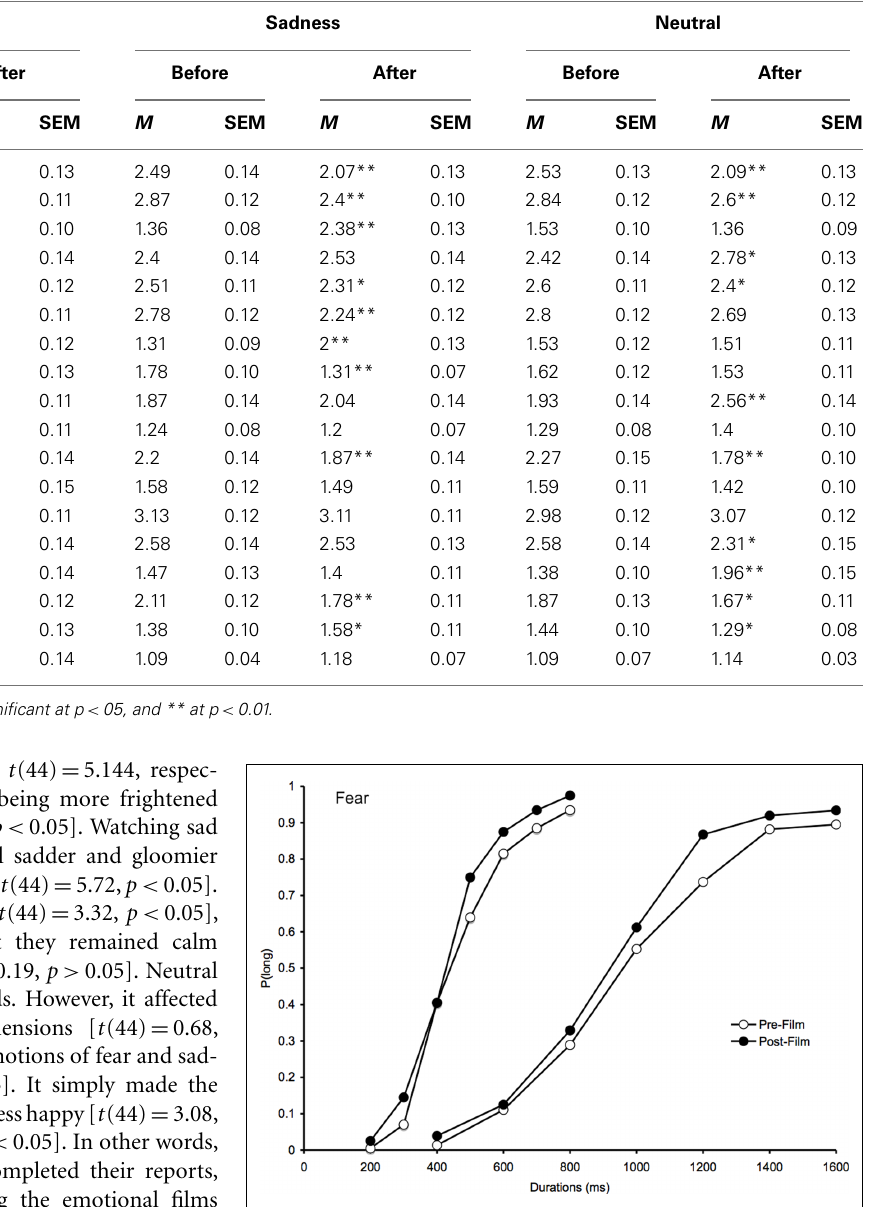
Table 1 | Mean rate ( M ) and SEM of experienced mood on 4-point scales for 18 mood adjectives of the French version of the Brief Mood